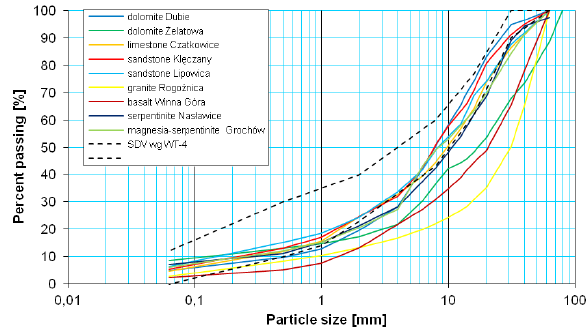
Figure 2: The curves of grain composition of the mixtures of 0–63 mm with the area of good granulation for subbase (SDV acc. to WT-4